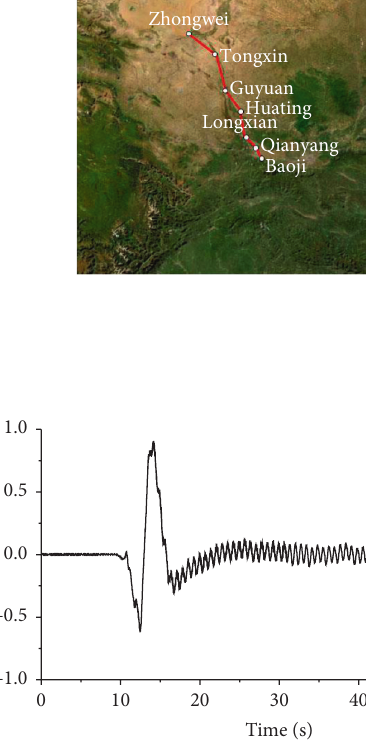
Figure 2: Time history diagram of dynamic displacement.